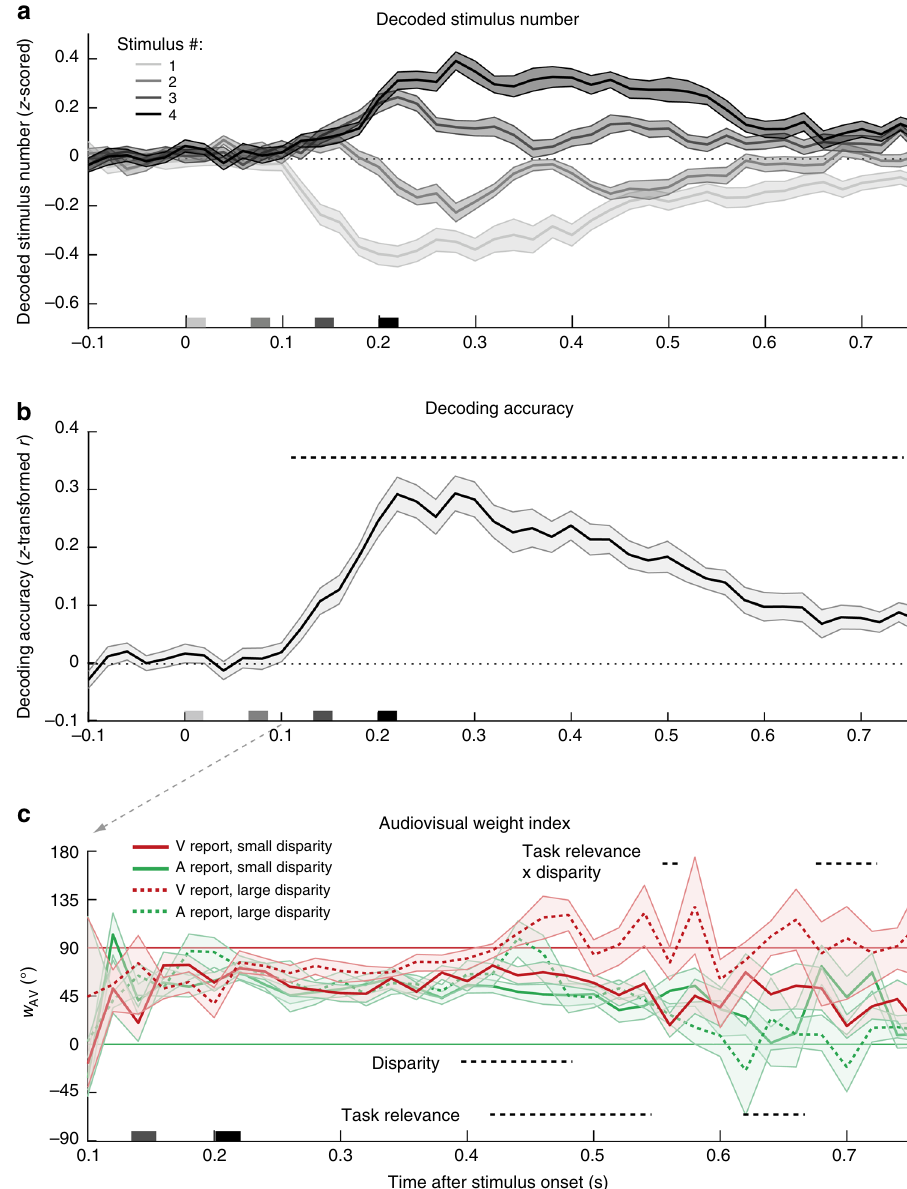
Fig. 3 Decoded stimulus number, decoding accuracy, and relative audiovisual weight index. a Decoded stimulus number in audiovisual congruent conditions (across-participants mean ± SEM; n = 23). Note that the stimulus numbers {1, 2, 3, 4} as labels were transformed to { − 1, − 0.33, + 0.33, + 1} before decoding such that the decoder predicts a stimulus value of 0 in case of no information on stimulus number in EEG activity patterns and decoded stimulus number was z scored in each run. Stimulus onsets are shown on the x axis. b Decoding accuracy (Fisher ’ s z -transformed correlation; across- participants mean ± SEM) of the decoders as a function of time. Decoding accuracy was computed as Pearson correlation coef fi cient between true and decoded stimulus number in audiovisual congruent conditions. Decoding accuracy was signi fi cant in a cluster from 120 – 740 ms ( p < 0.001, one-sided cluster-based corrected randomization t 22 test; see horizontal dashed line). c Neural audiovisual weight index w AV (across-participants circular mean and bootstrapped 68% CI) as a function of numeric disparity (small vs. large), task relevance (visual (V) vs. auditory (A) report) and time. w AV = 90° for purely visual and w AV = 0° for purely auditory in fl uence. Horizontal dashed lines indicate signi fi cant clusters for effects of numeric disparity, task relevance and their interaction ( p < 0.05; cluster-based corrected randomization test based on an LRTS statistic, cf. Table 1). Source data are provided as a Source Data fi